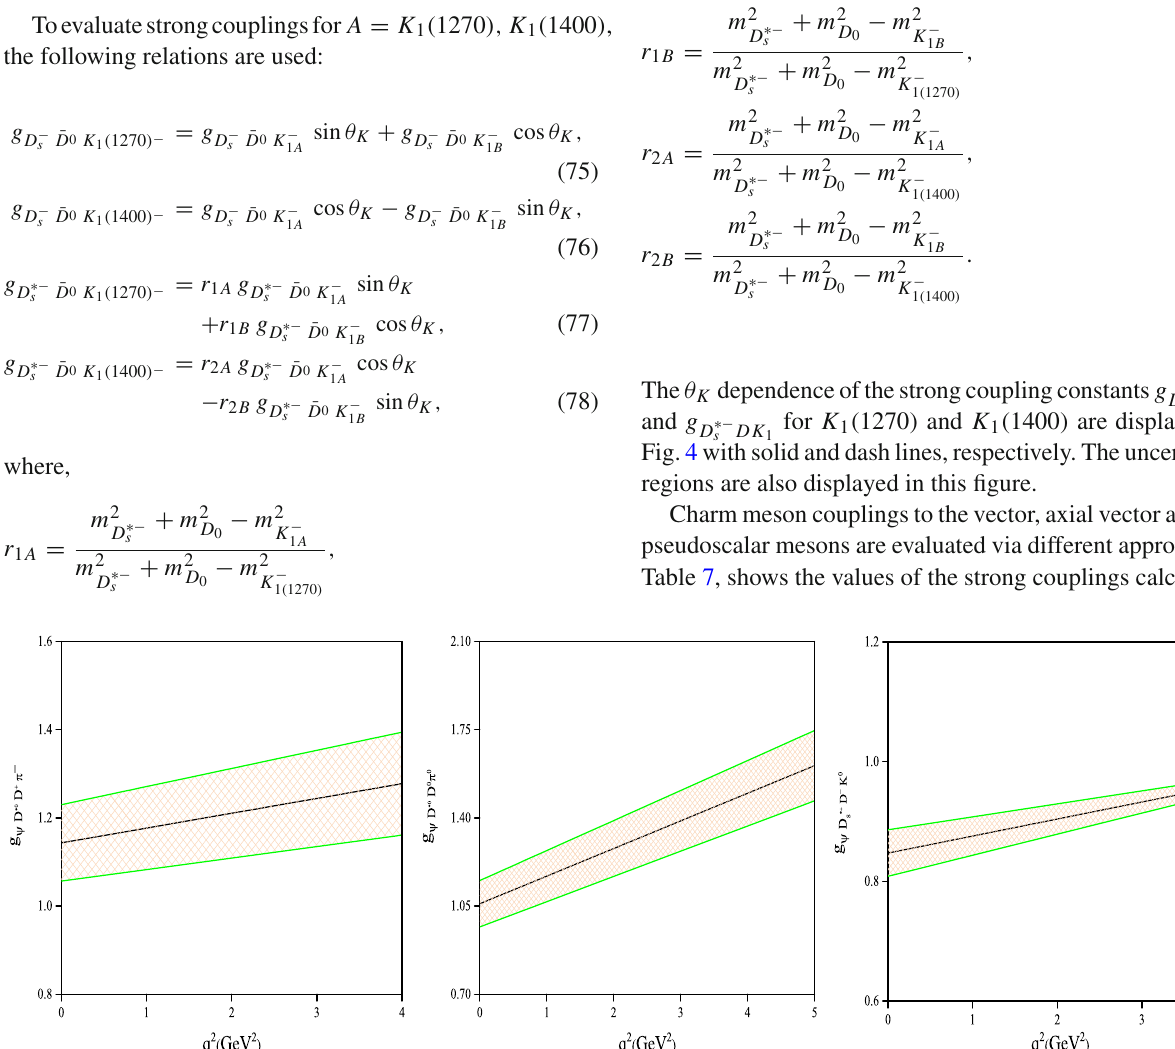
and g ψ for K 1 = K 1 ( 1270 ), K 1 ( 1400 D + s D − K 0 1 D ∗− s D − K 0 1